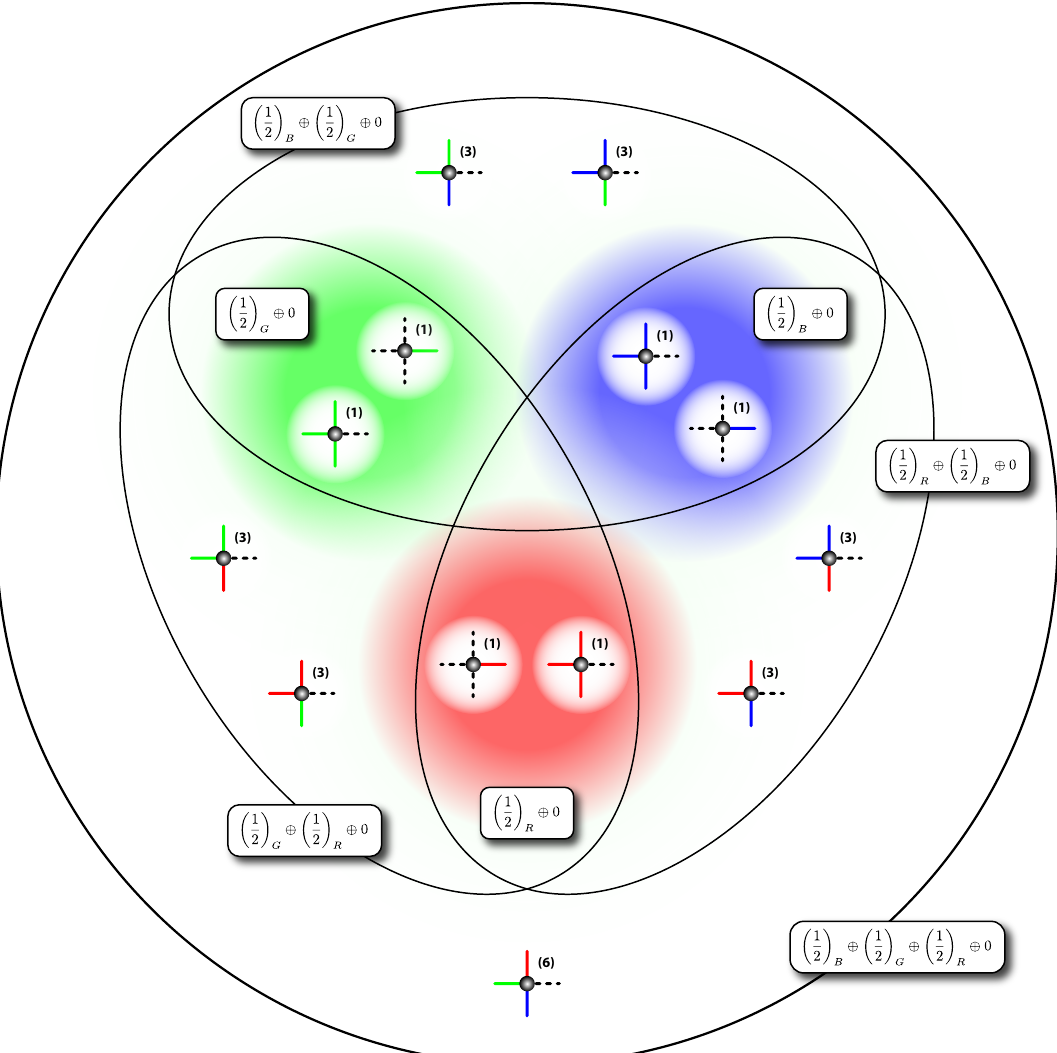
Figure 1: N -color RVB manifolds ( N = 1,2,3) spanned by onsite PEPS tensors in- volving, on their four virtual bonds, one, two and three colors (here blue, red and green) of spin-1 / 2 virtual degrees of freedom. The spin-0 degrees of freedom (site physical variables) are shown as dashed virtual legs (grey bullets) and the number of linearly independent (point group-symmetric) tensors of each kind is shown in parenthesis. All tensors contain either one or three spin-0 legs. The inner ensembles ⊕ 0 PEPS manifold (each spanned correspond to three (identical) copies of the V = 1 2 by two site tensors). Each of the three copies of the N = 2 PEPS family is spanned by 2 × 2 = 4 single-color tensors and, simultaneously, by a set of six 2-color tensors. The D = 7 3-color RVB subspace is spanned by all the 30 tensors of the